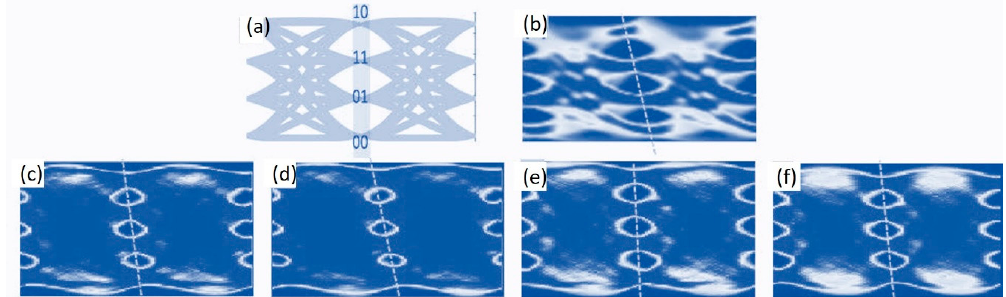
Figure 5. The eye diagrams of ( a ) ideal PAM4 signal; ( b ) simulated PAM4 at 50 Gb/s using spatial- temporal modeling, ( c ) measured 56 Gb/s PAM4 signal when bias current is 5 mA; ( d ) measured 64 Gb/s PAM4 signal when bias current is 5 mA; ( e ) measured 56 Gb/s PAM4 signal when bias current is 7 mA; ( f ) measured 64 Gb/s PAM4 signal when bias current is 7 mA (reprinted from [64] with permission from authors).